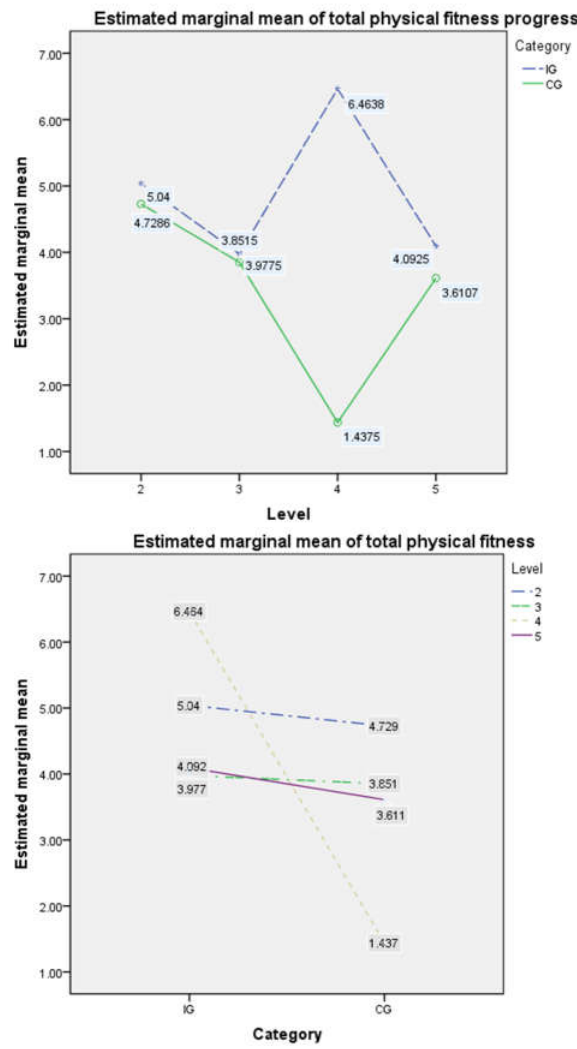
Figure 3. The interaction effect between the intervention and the level of progress of physical fitness scores after the experiment.